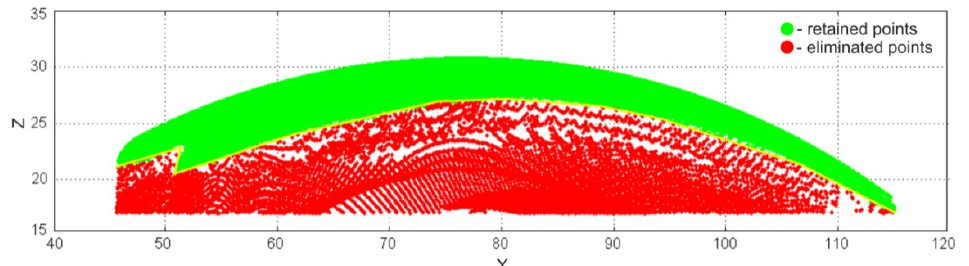
Figure 21. The result of filtering by segmented line.